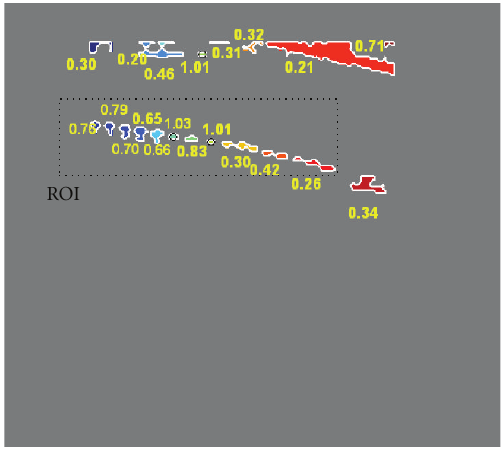
Figure 8: Circularity of objects.